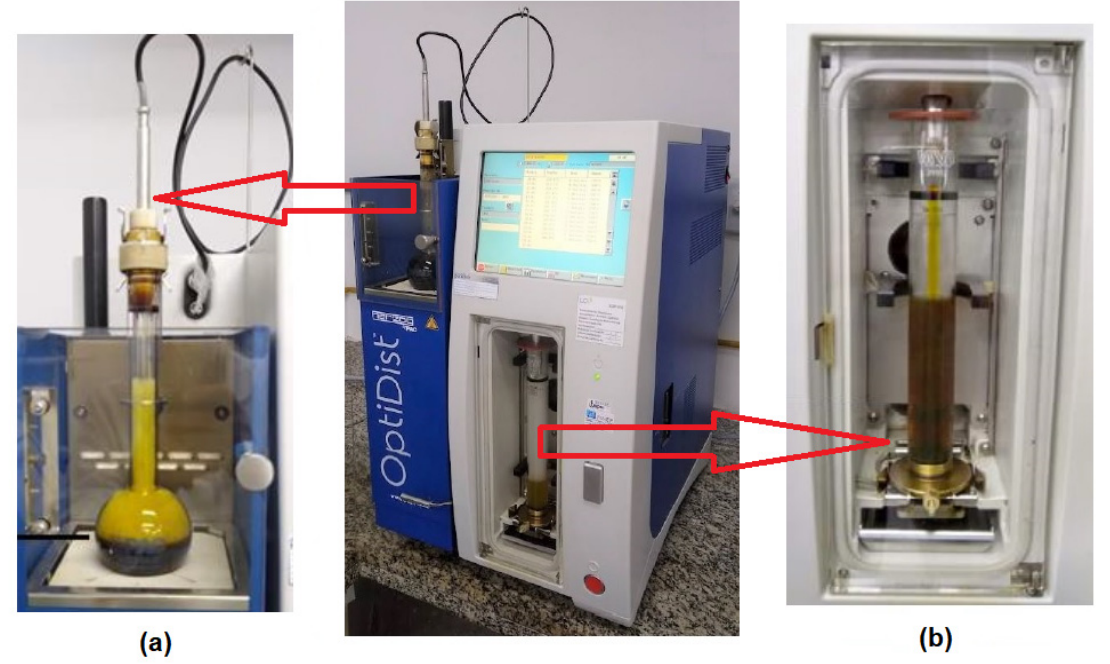
Figure 10. Equipment used for automatic distillation according to ASTM D86: ( a ) the reactor containing the atmospheric residue of the petroleum and catalyst; ( b ) glass measuring cylinders with 100 mL capacity to collect the distilled products.